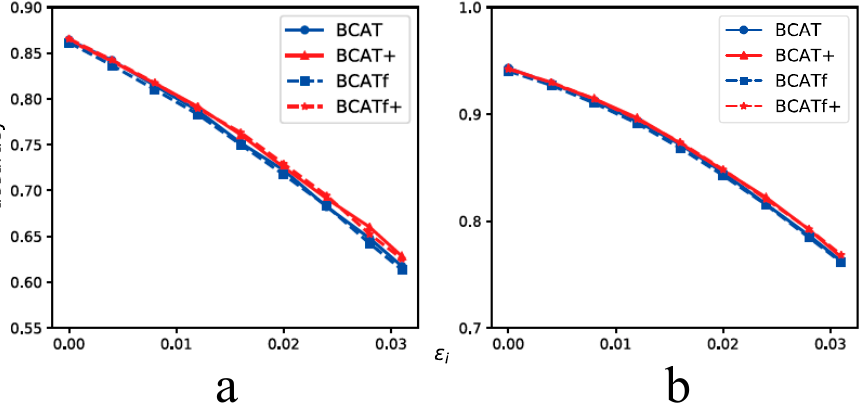
Figure 10. Standard generalization and robustness generalization curves of BCAT (+) and BCATf (+) on CIFAR-10 and SVHN. ( a ) CIFAR-10. ( b )